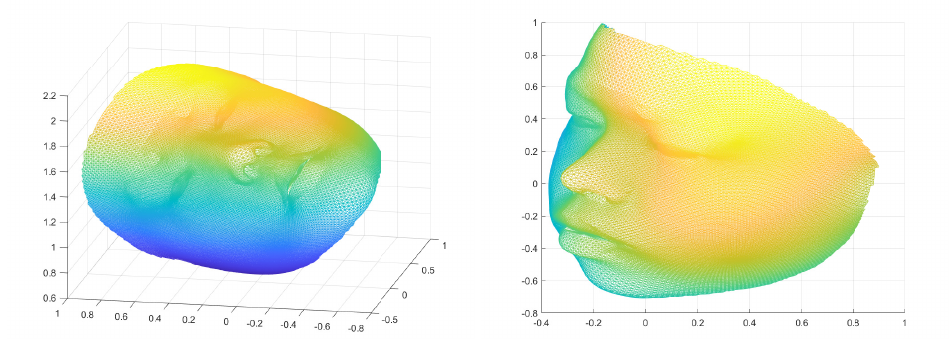
Figure 1. Demonstration of the 3D facial model reconstructed from 2D